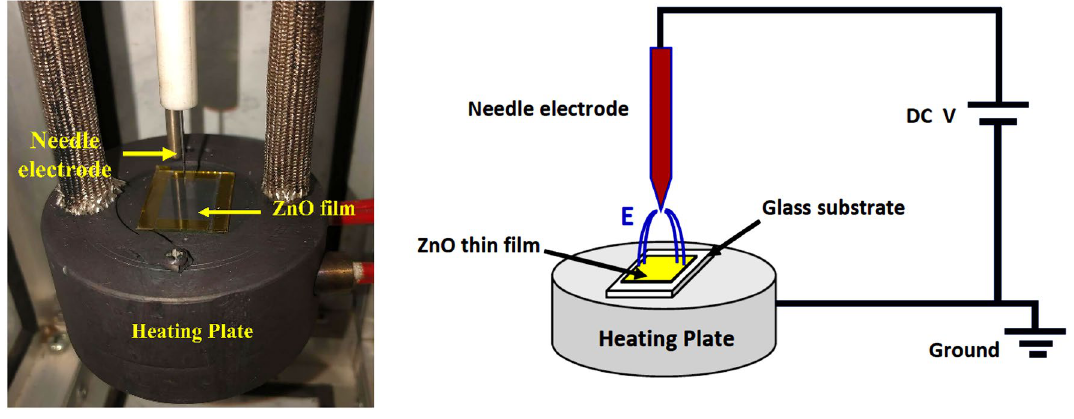
Figure 1. Schematic of Corona poling